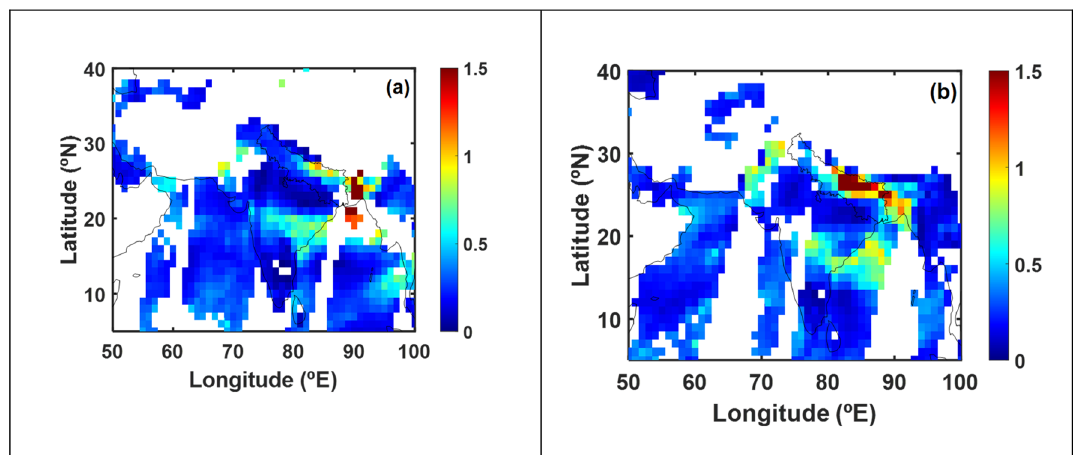
Figure 4. AR-driven changes in aerosol optical depths (AOD) over the Indo-Gangetic Plains for an event on Jan 24–25, 2020. The distribution of AOD on two consecutive days, ( a ) AOD on Jan 24, 2020 at 10.30 local time and ( b ) AOD on Jan 25, 2020 at 10.30 local time, which corresponds to before and after passage of AR event over IGP. The mean AOD values over IGP for Jan 24, 2020 and Jan 25, 2020 are 0.36 ± 0.25 and 0.92 ± 0.66 respectively. White color in figures represents non-availability of data. Figure is generated using MATLAB R2020a software available at http:// in. mathw orks. com/ produ cts/ matlab/. (License no: